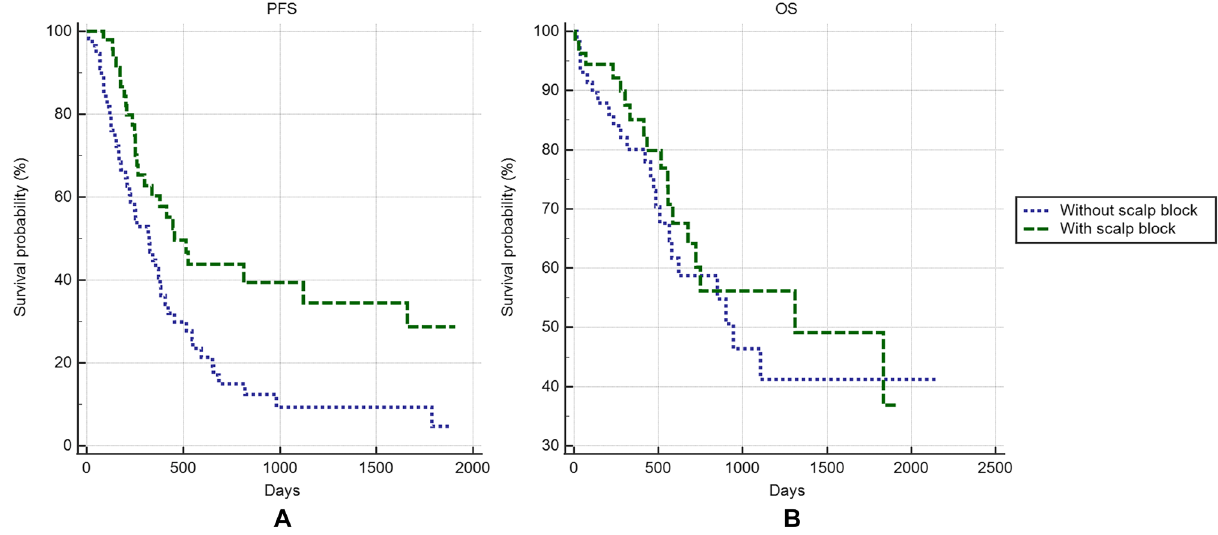
Figure 2. Oncological outcomes between patients who received scalp block and those who did not.